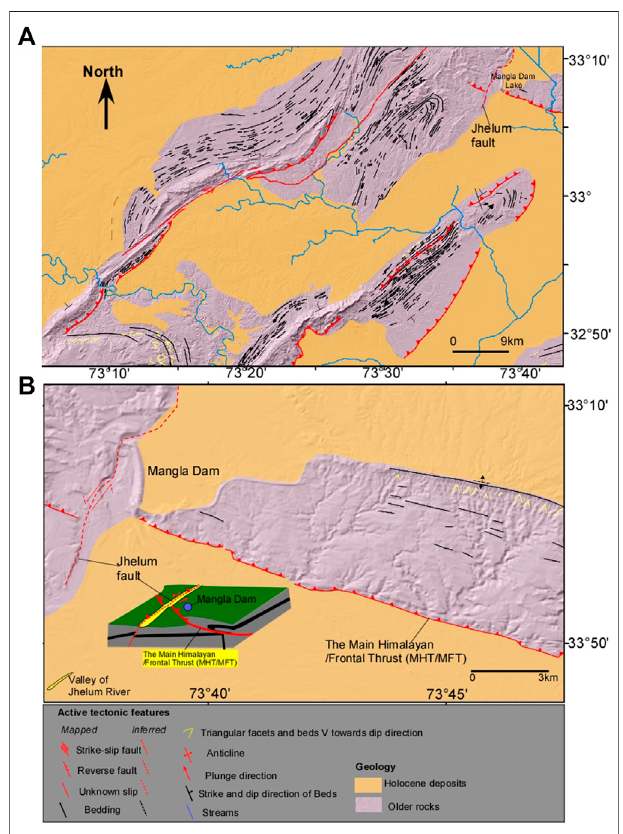
FIGURE6| theinterpreted shuttleradartopography(30 mresolution)of the middle (A) and lower (B) portions of the Jhelum fault (JF) system (see locationin Figure1 )withevidenceofactivefaulting.NotetheMainHimalayan/ Frontal Thrustiscutby theJF,whichclearly indicates active faulting. The plunging folds mapped in the eastern portions of the JF are truncated at the emergenceoftheJFsystem,andthisindicates thattheirdeep structural roots are linked with the